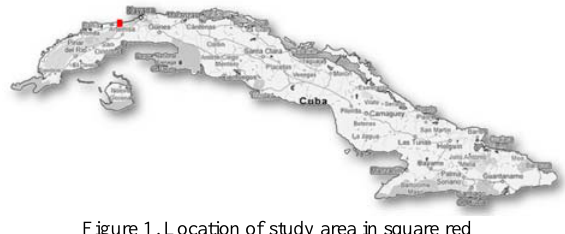
Figure 1. Location of study area in square red